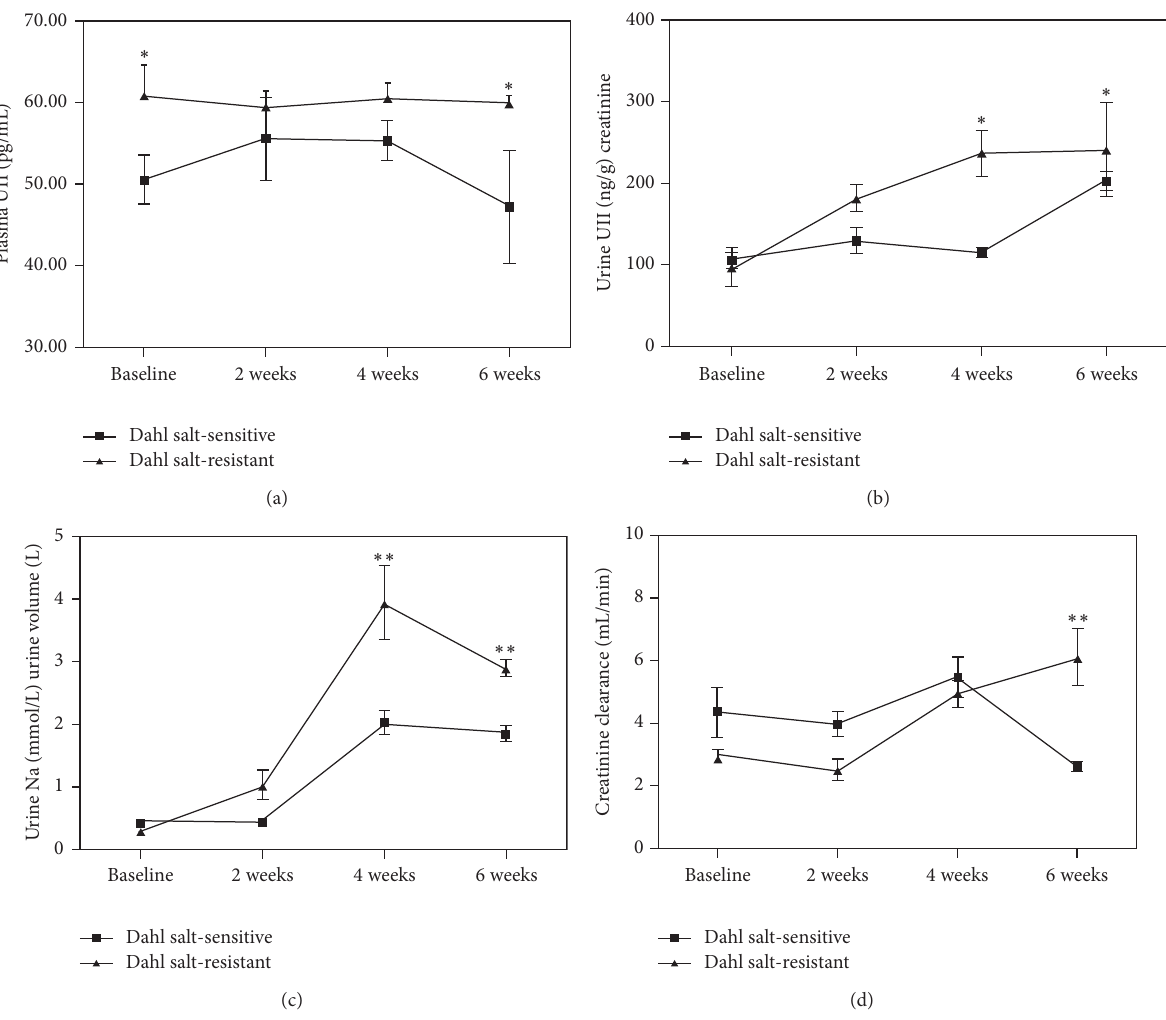
Figure 2: Figure 2 demonstrated the changes of plasma UII, urinary UII, 24-hour urinary sodium excretion, and creatinine clearance between SR rats and SS rats after high-salt forage feeding for 6 weeks. ∗ 𝑃 < 0.05 versus SS group; ∗∗ 𝑃 < 0.01 versus SS group (a, b, c, and d).